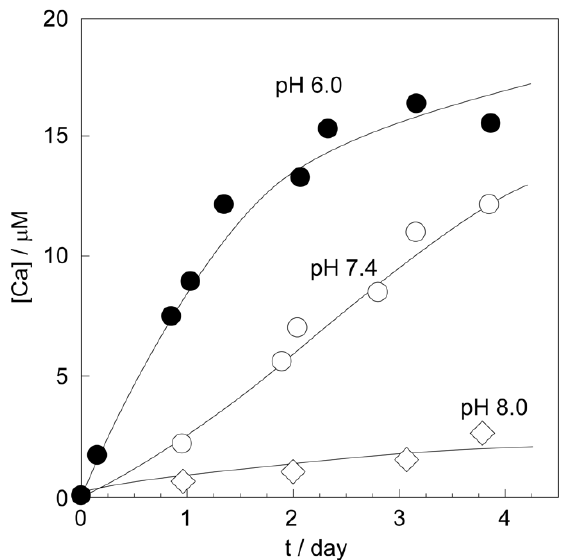
Figure 7. The concentration changes in free Ca 2+ produced by the dissolution of the CaCO 3 shell under various pH conditions of pH 8.0, pH 7.4, and pH 6.0,